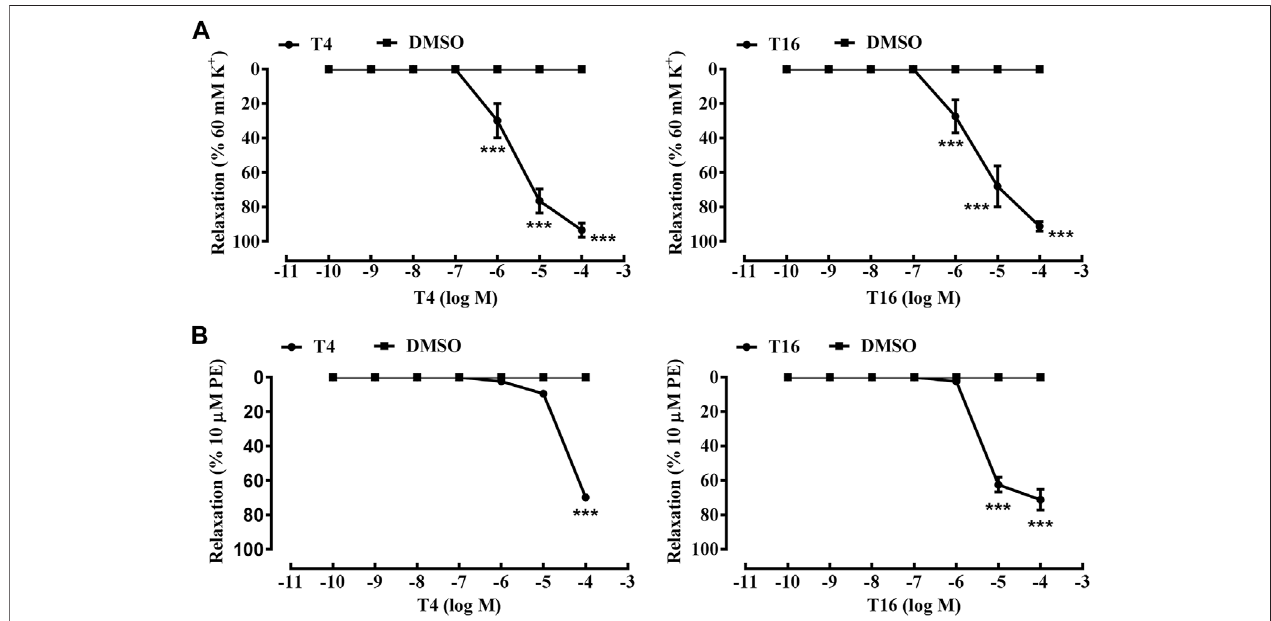
FIGURE 7 | Vasodilation effects of compounds T4 and T16 on superior mesenteric artery rings in vitro pre-contracted by KCl (60 mM) or by phenylephrine hydrochloride (PE, 10 μ M). (A) KCl. (B) PE. *** p < 0.05 versus a DMSO control ( n (cid:1) 3) indicates a signi fi cant difference compared with the control (DMSO).